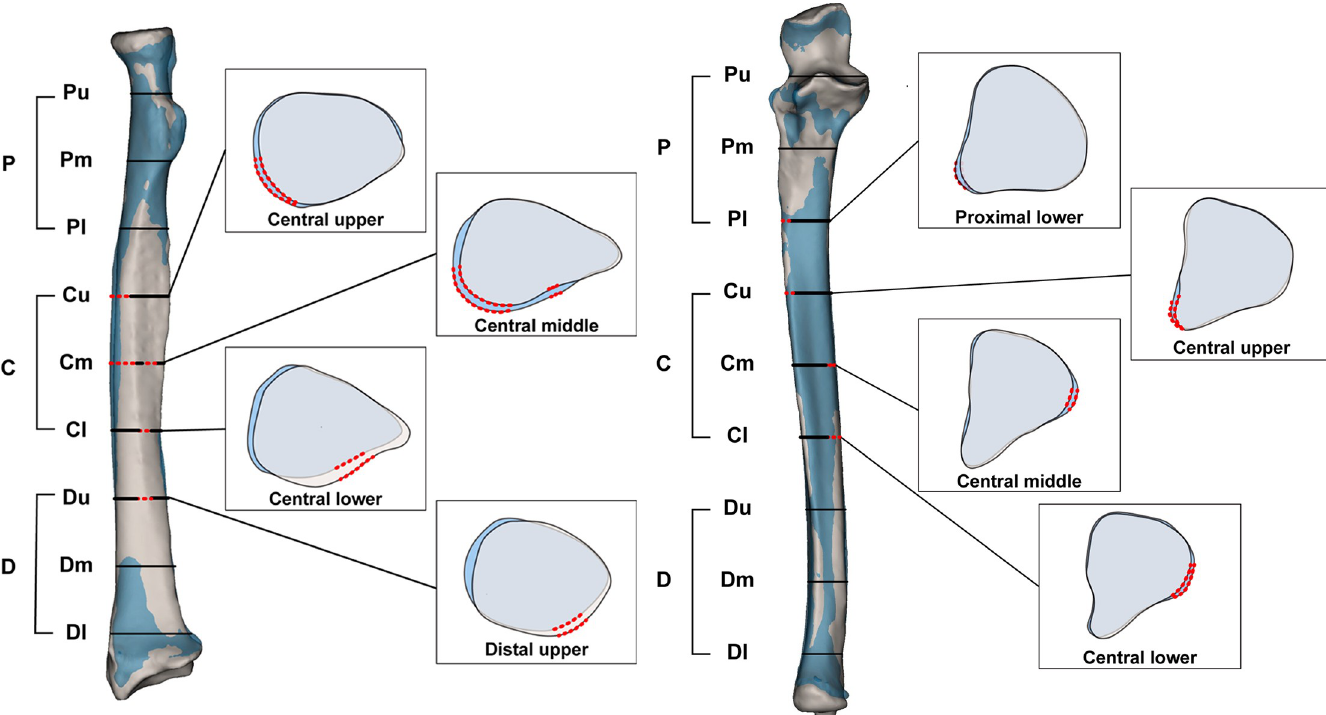
Fig 5. Regional shape difference of the radius and ulna. Angles with significant shape differences between bilateral bones are marked with dotted red lines on each cross-sectional image. P , proximal; C , central; D , distal; Pu , upper section of the proximal part; Pm , middle section of the proximal part; Pl , lower section of the proximal part; Cu , upper section of the central part, Cm , middle section of the central part, Cl , lower section of the central part, Du ; upper section of the distal part, Dm ; middle section of the distal part, Dl ; lower section of the distal part.